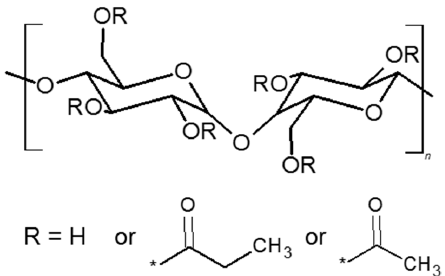
Figure 1. Chemical structure of cellulose acetate propionate.